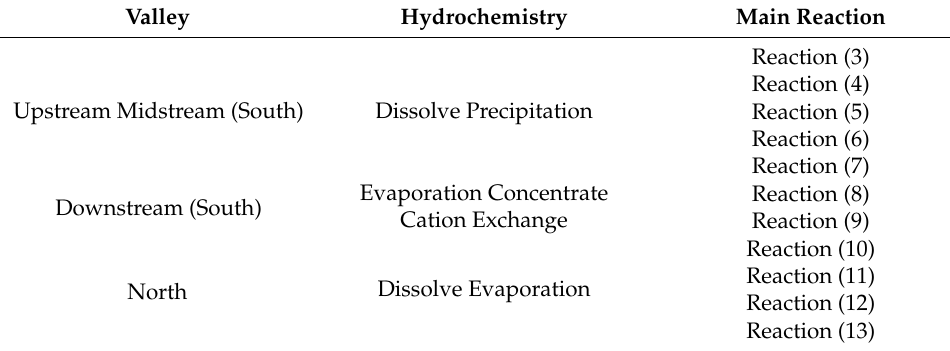
Reaction (3) Reaction (4) Reaction (5) Reaction (6) Reaction (7) Reaction (8) Reaction (9) Reaction (10) Reaction (11) Reaction (12) Reaction